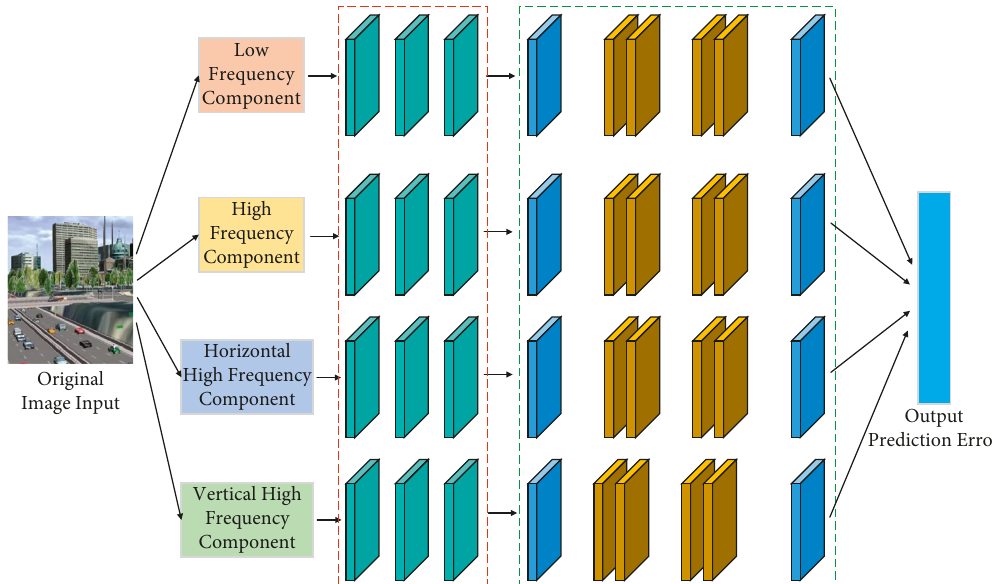
Figure 2: Wavelet transform denoising model combined with residual